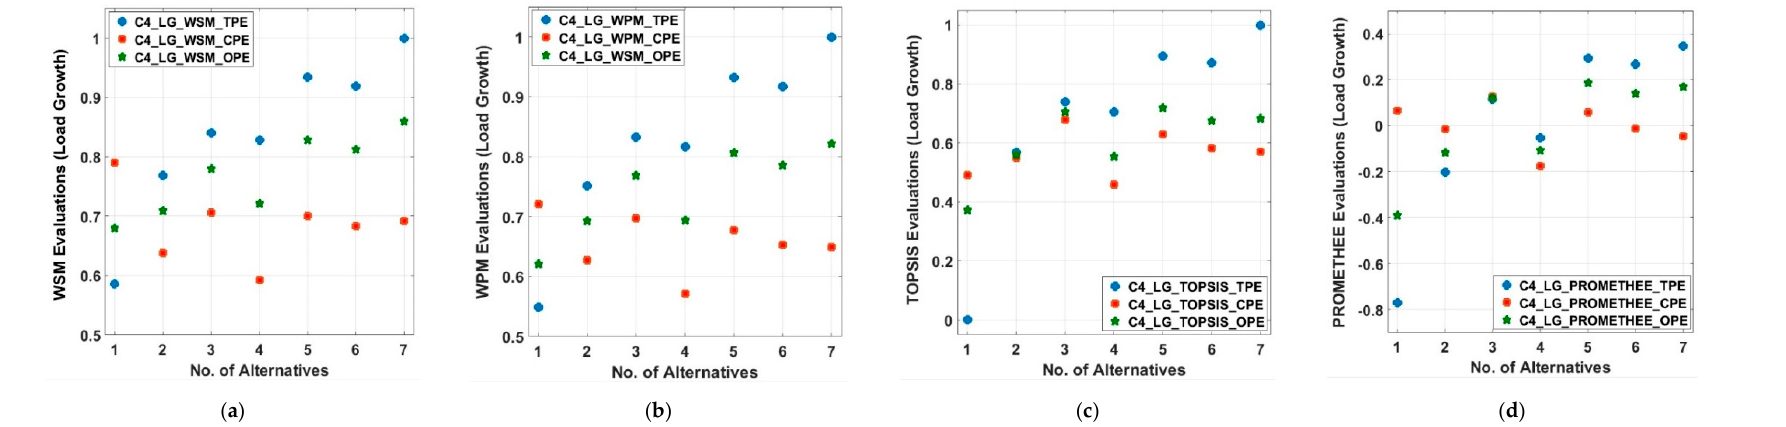
Figure 12. MCDM evaluations for C4_LG in 33-bus MDN: ( a ) WSM scores; (b) WPM scores; ( c ) TOPSIS scores; ( d ) PROMETHEE scores. Table 20. Order of the ranks across TPE, CPE, and OPE in C4_LG for 33-bus MDN.